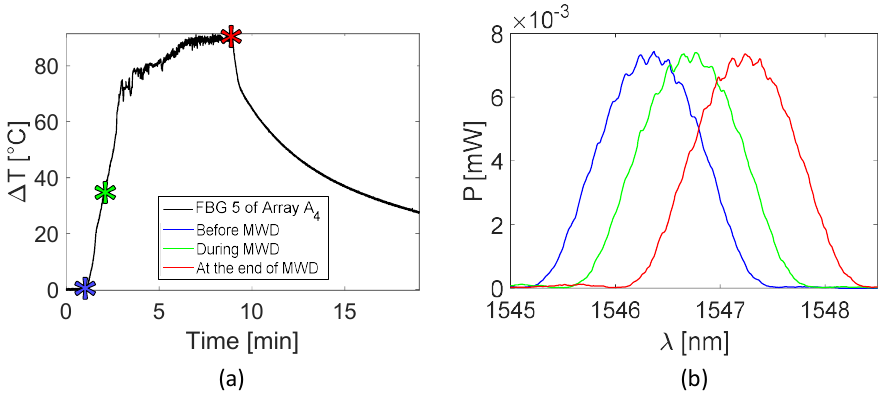
Figure 5. Focus on the fifth FBG belonging to array A 4 , the sensor which recorded the maximum temperature value during the MWA treatment: ( a ) temperature variation versus time; ( b ) optical reflected spectra before, during and at the end of the MW discharge (MWD) in the three different instants of time marked in ( a ), plotted in blue, green and red respectively.